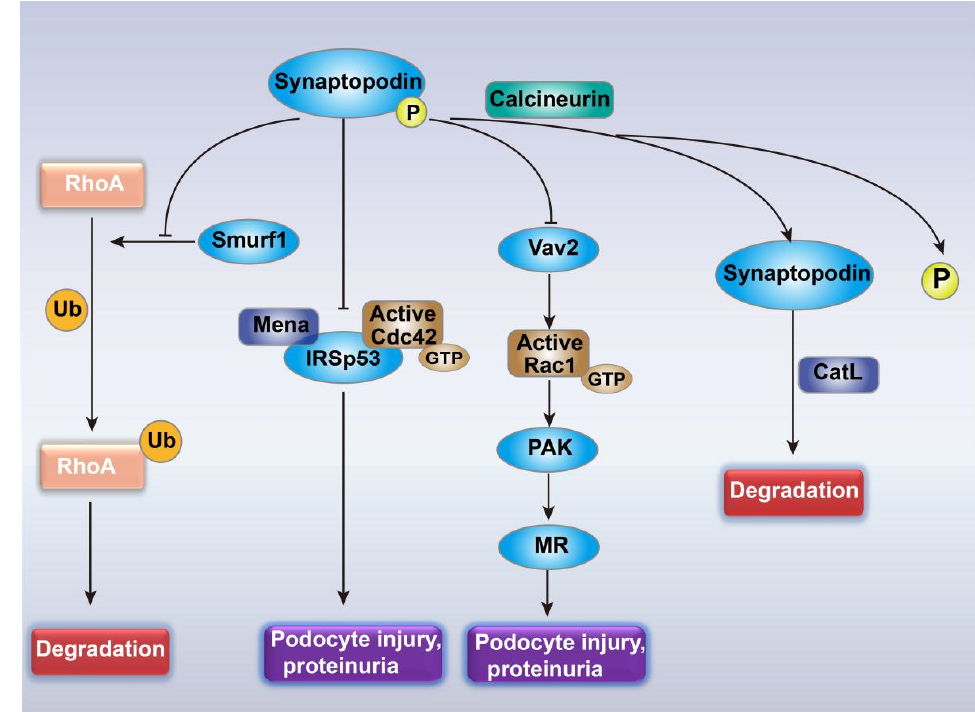
Figure 2. The connection between proteinuria and Rho GTPase family. Abbreviations: CatL, cathepsin L; Mena, an Ena/VASP family protein; IRSp53, insulin receptor substrate 53; Smurf1, smad ubiquitination regulatory factor 1; Vav2, a guanine nucleotide exchange factor; PAK, p21-activated kinase; MR, mineralocorticoid receptor. P, phosphorylation; Ub, ubiquitination.